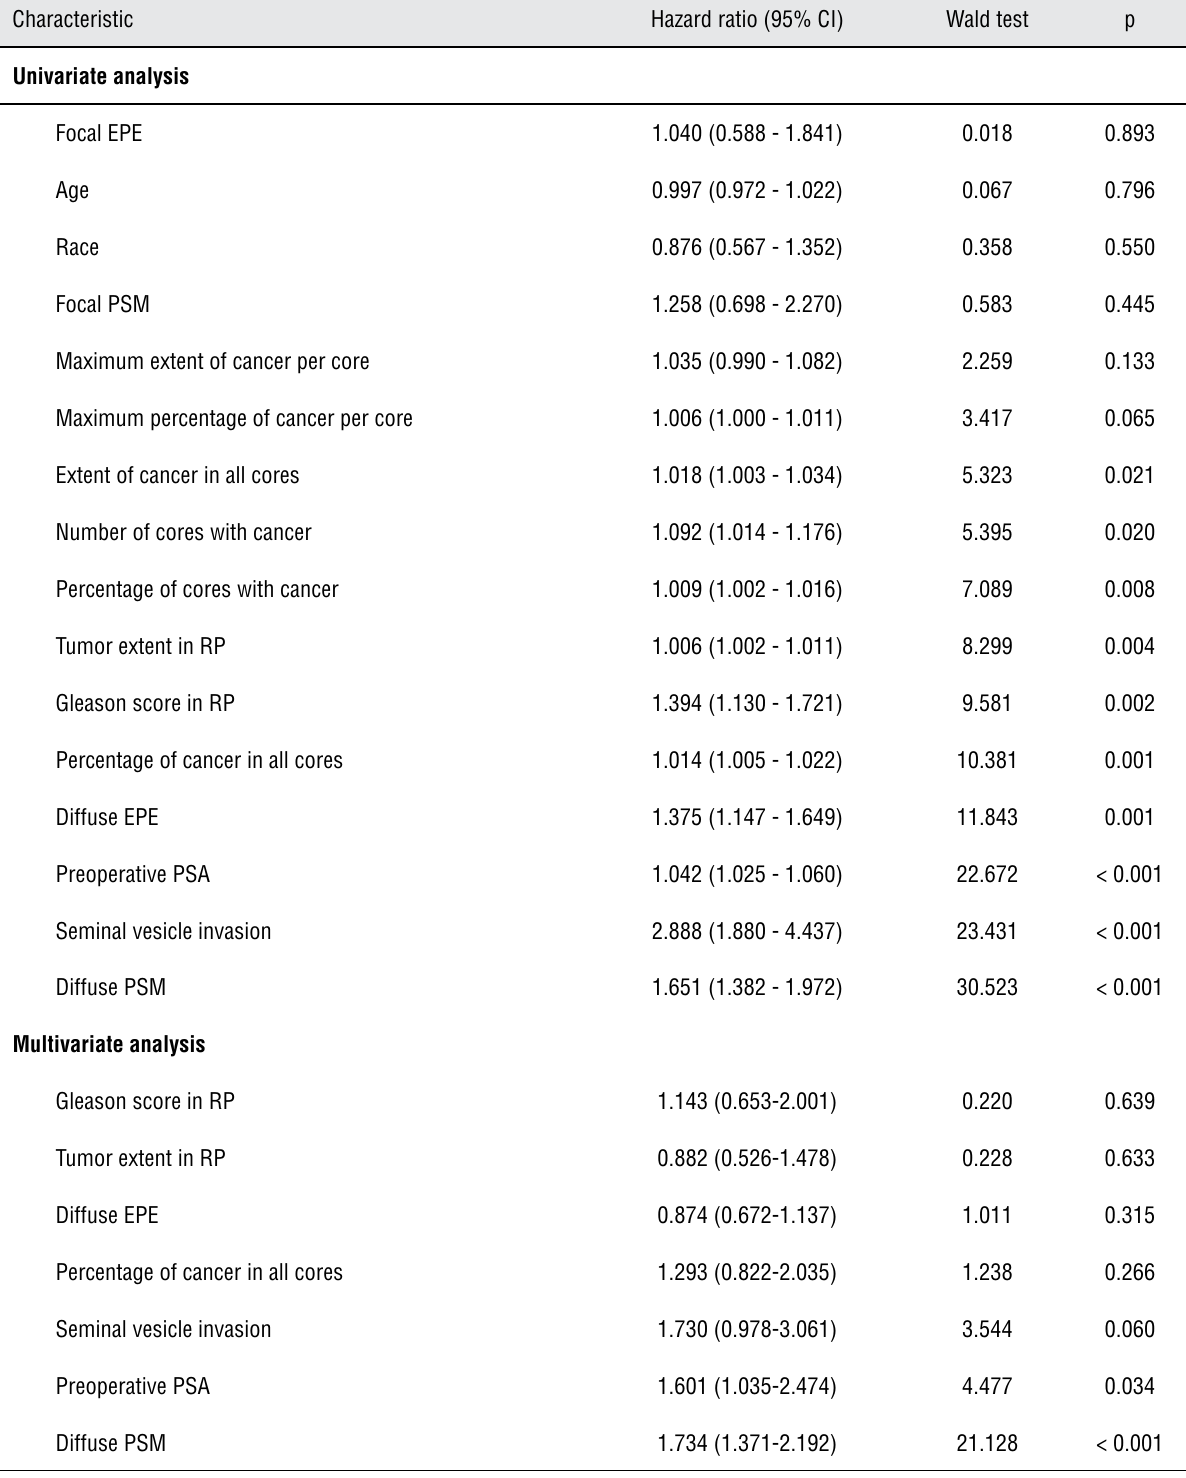
Table 3 - Cox univariate and multivariate proportional hazard analysis of several clinicopathologic characteristics predicting shorter time to biochemical recurrence following radical prostatectomy. CI, confidence